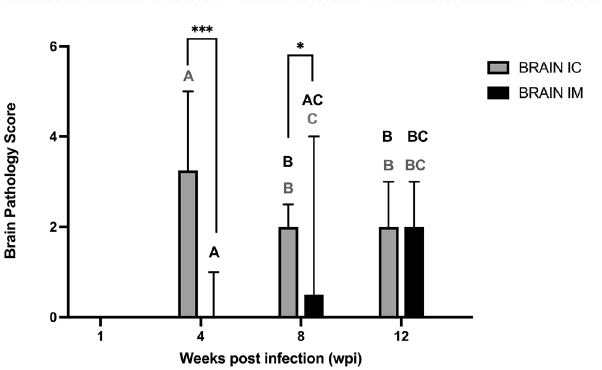
Figure 2. Graph showing the overall brain scores of inflammation in Muscovy ducks experimentally infected with aquatic bird bornavirus 1 (ABBV-1) through the intracranial (IC) or intramuscular (IM) routes of infection, and assessed at 1, 4, 8, and 12 weeks post infection (wpi). Significant differences between terms within the same time point are identified with simple binary connectors. Significant differences of terms at 4 wpi and terms at other time points are identified by different letters and color-coded (IC, grey; IM, black). Pairwise comparisons with data points scoring 0 (no inflammation) are not represented. Data columns represent median with data range. Krurskal-Wallis test with Benjamini, Krieger, and Yekutieli procedure for false discovery rate (* < 0.05, ** < 0.01, *** <